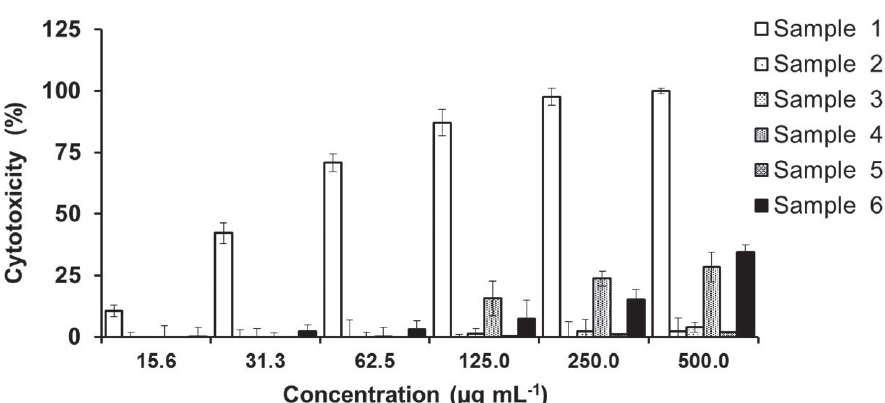
FIGURE 3 - Cytotoxic effects of commercial available aqueous extracts of Tribulus terrestris (Samples 1 to 5) and the aqueous extract of the aerial parts of Tribulus terrestris (Sample 6) evaluated against hepatocarcinona cell line (Hepa 1c1c7). Values represent the percentage of cell death ± SD of three independent experiments tested by the MTT assay.